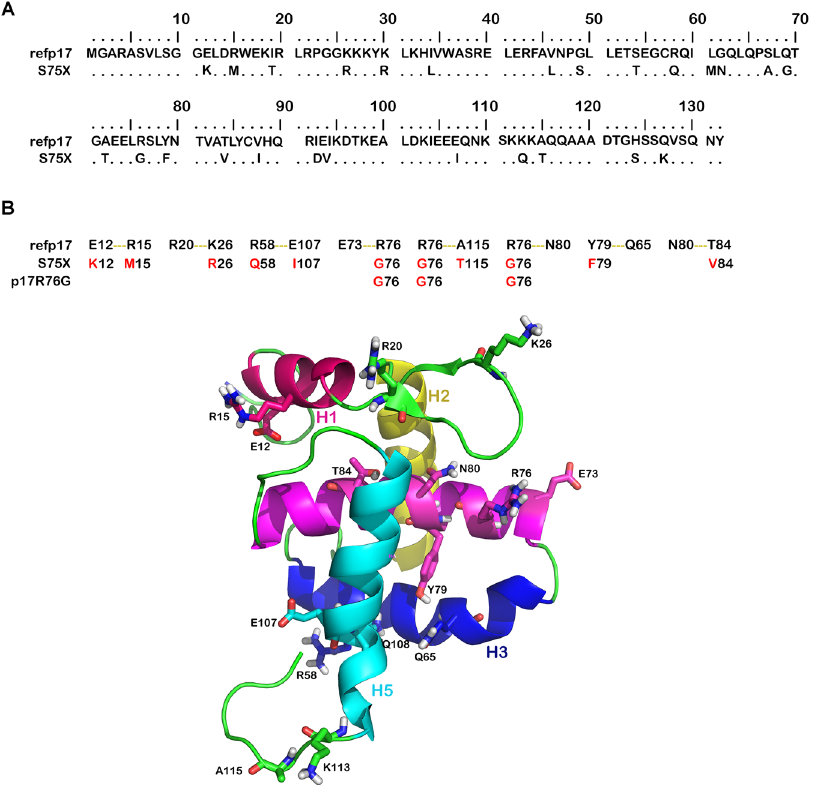
Figure 1. Sequence and hydrogen bond network of refp17 and S75X. ( A ) Sequences are represented by the single-letter amino acid code. The amino acid sequence (aa 1–132) of the matrix protein clade B isolate BH10 p17 (UniProtKB P04585) was adopted as reference (refp17) for this analysis. Each amino acid residue of S75X not differing from refp17 sequence is represented by a dot. ( B ) At the top of the Figure, in the first row, the residues involved in the hydrogen bond network of p17 are shown and below the residues mutated in the variants S75X and p17R76G are indicated. The residues involved in hydrogen bond network are shown as